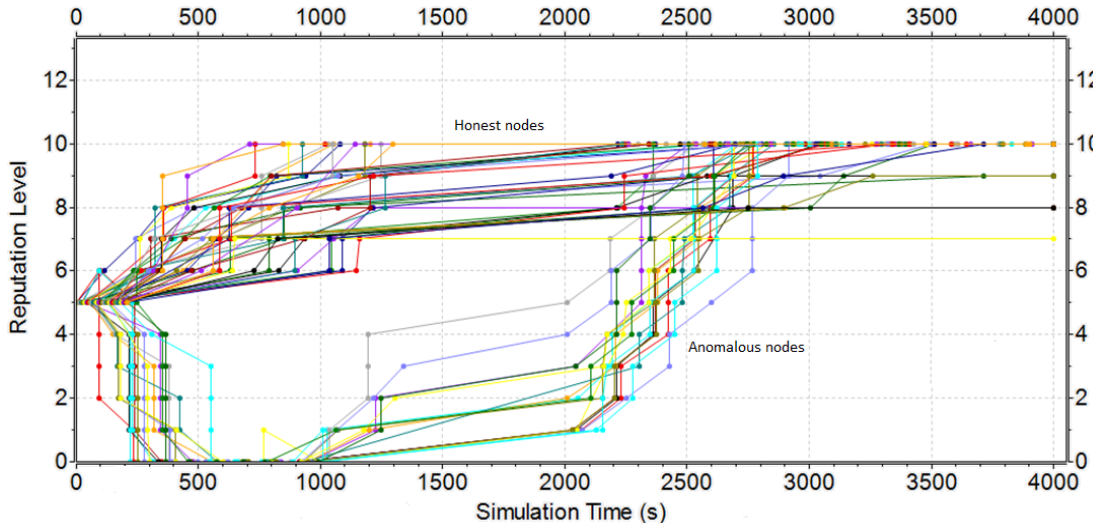
Figure 11. Reputation evolution for Newcomer attack—Manhattan-Grid Scenario.